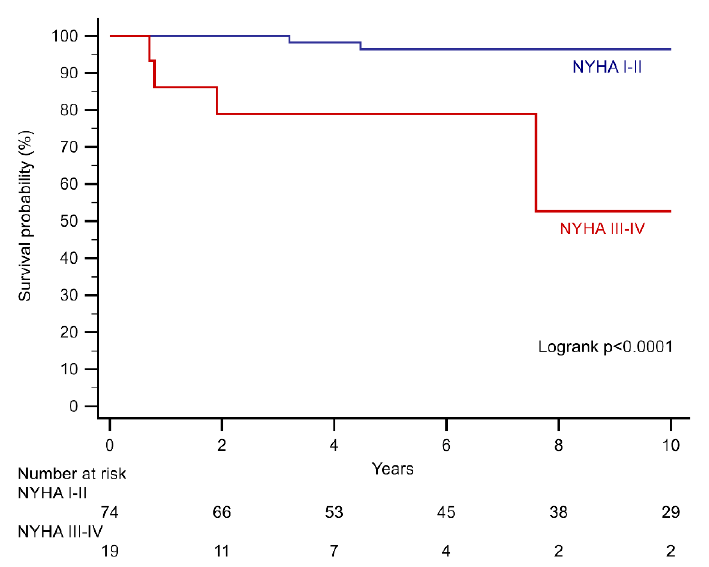
Figure 4. Kaplan–Meier curves stratifying patients according to NYHA class at baseline.